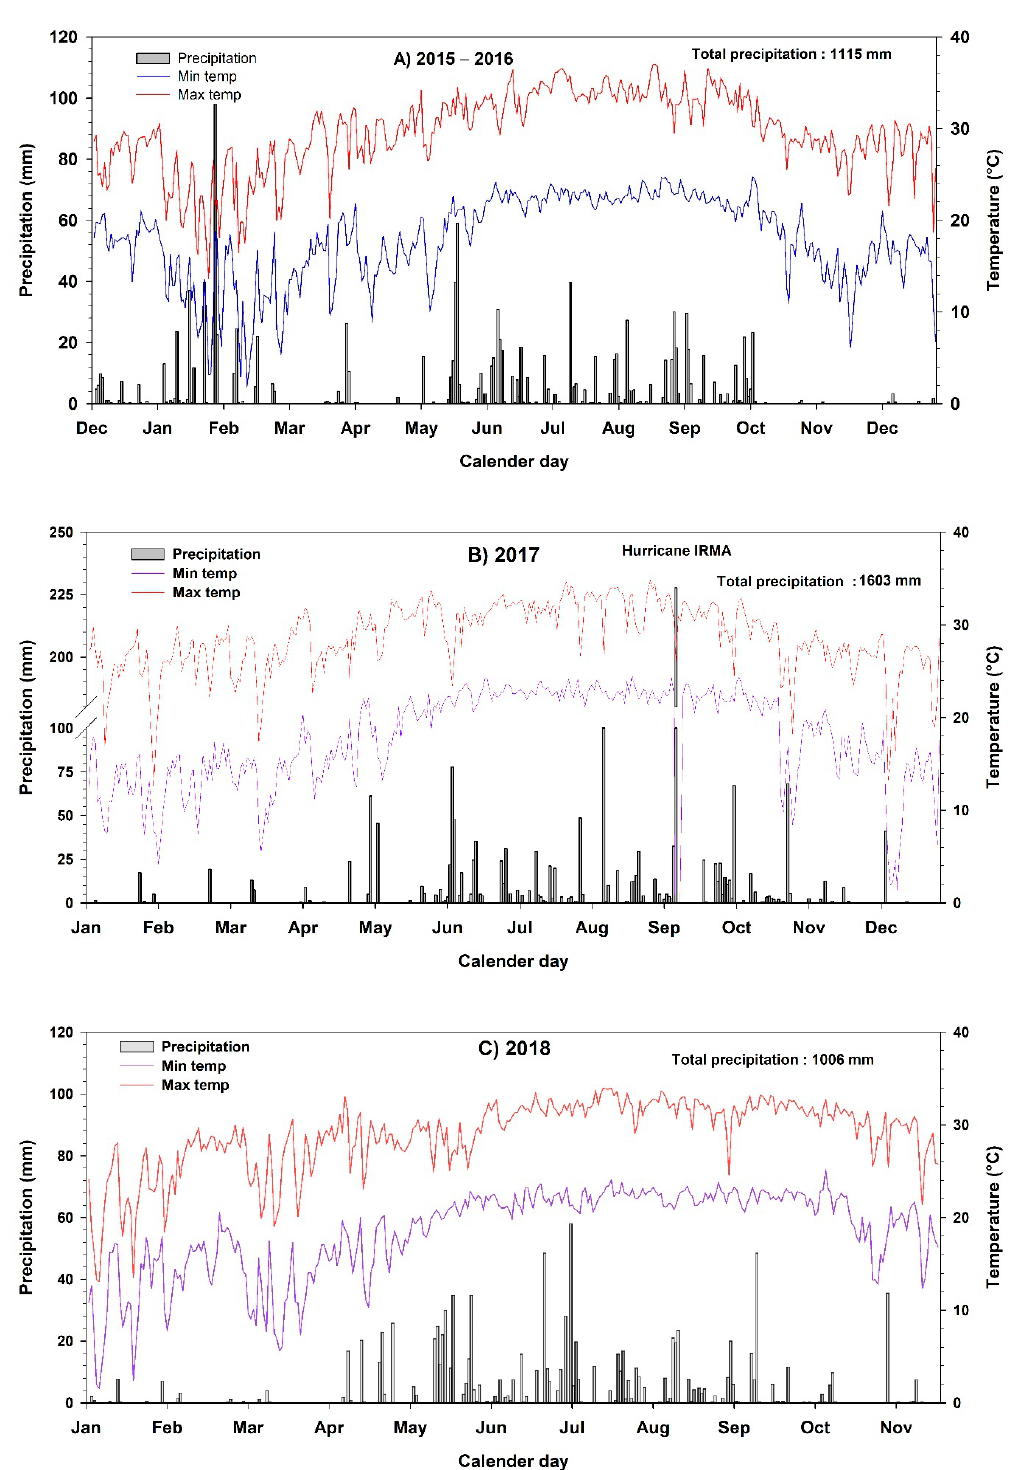
Figure 1. Daily precipitation and air temperatures (minimum and maximum) during the experimental years ( A ) 2015–16, ( B ) 2017, and ( C ) 2018.